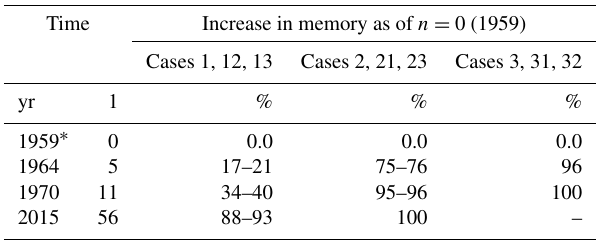
Table 2. Cases 1–3 and related experiments: build-up of mem- ory (%) as of n = 0